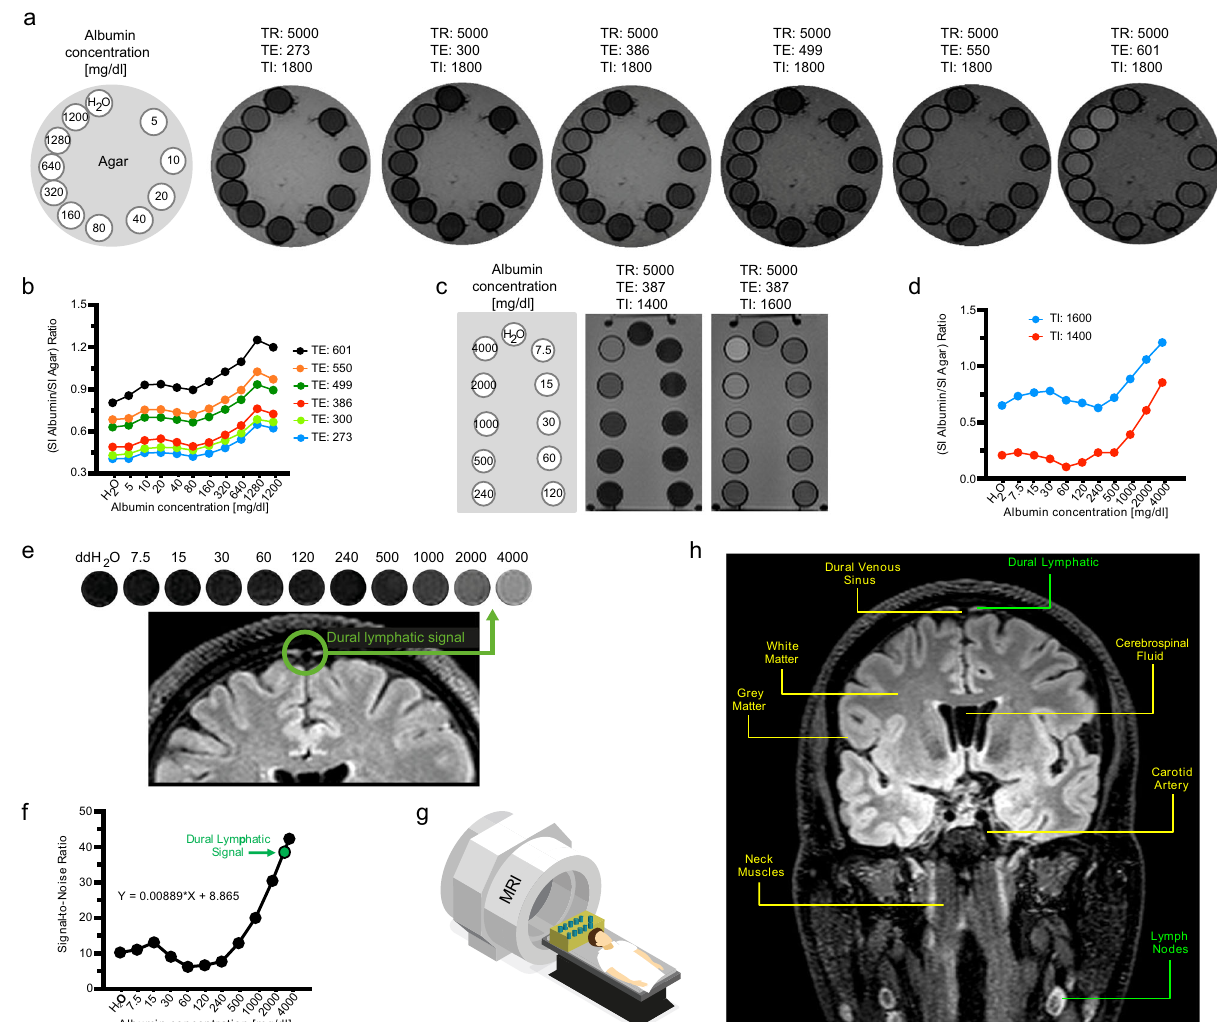
Fig. 1 Phantom studies of head and neck structures using 3D-T2 FLAIR. Echo time (TE) related changes in 3D-T2 FLAIR signal can be seen in six phantom images ( a ), with the strongest signals observed at TE 601 in solutions of higher protein concentrations. The ratio of albumin signal intensity (SI) to agar SI with respect to albumin concentration can be seen in ( b ). Increasing TE values resulted in increasing signal-noise-ratio (SNR) across the protein samples analyzed, with the highest SNR observed at TE of 601 ms. The rectangular phantom images depict inversion time (TI) related signal changes related to albumin concentration ( c ). Signal suppression of water was more prominent at TI 1400 ms, and signal was signi fi cantly greater at all protein concentrations at TI 1600 ms. The ratio of SI albumin to SI agar with respect to albumin concentration can be seen in ( d ) for IR 1400 ms and 1600 ms. The greater TI value of 1600 ms yielded a greater SNR across the protein samples analyzed. Simultaneous MR imaging was performed of a rectangular phantom and a healthy adult male subject ( e – g ). Parasagittal dural lymphatic signal intensity corresponds to that of the higher albumin concentrations between 2000 and 4000 mg/dl ( e ). SNR shows a positive relationship with albumin concentration up to 15 mg/dl, then a negative relationship from 15 to 60 mg/ dl, followed by a marked increase in SNR between 60 and 4000 mg/dl ( f ). An example image identifying key structures in the head and neck region from which signal intensity measurements were obtained, including the cervical lymph nodes and parasagittal dural lymphatics, is provided in ( h ). These fi ndings demonstrate that this T2-FLAIR sequence ’ s parameters are sensitive to lymphatic fl uid and lymphatic tissue without the need for contrast agents. TR relaxation Intra-rater reliability . The intra-class correlation coef fi cient values for intra-rater reliability ranged between 0.983 and 1 for SI values and between 0.995 and 1 for thickness values ( p < 0.001 for all). The intra-rater variability was excellent at all regions tested for these ten cases.